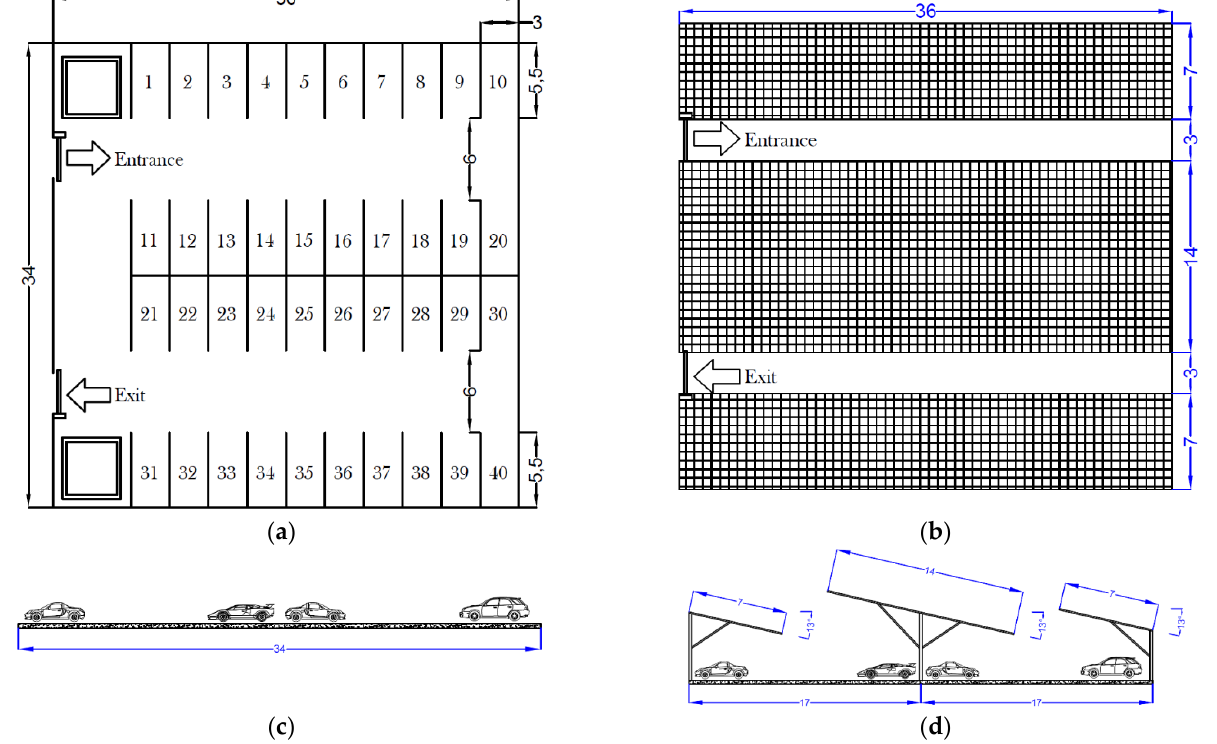
Figure 6. Plans before and after building the roofs for the PV system in an EVPL. ( a ) Floor plan: before building the roofs, ( b ) Floor plan: after building the roofs, ( c ) Front elevation: before building the roofs, ( d ) Front elevation: after building the roofs.